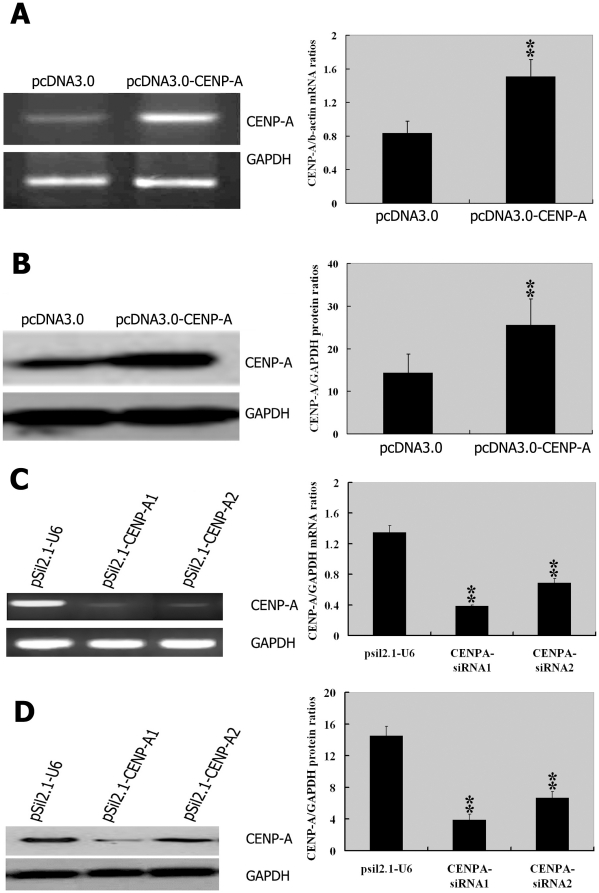
CENP-A overexpression and knockdown in HepG2 cells.Analysis of CENP-A mRNA (A, C) and protein (B, D) levels in HepG2 cells transfected with CENP-A-expressing plasmids or siRNA-expressing plasmids, as described in Materials and methods. A: RT-PCR (left) and qPCR (right) measurement of CENP-A transcript in cells transfected with pcDNA3.0-CENP-A or pcDNA3.0 empty vector. **
P<0.01 using Student's t-test; n = 3. B, left: Representative Western blots for CENP-A in cells treated as in A. Right: Quantification of the blotting shown in the left panel. **
P<0.01 using Student's t-test; n = 3. C: RT-PCR (left) and qPCR (right) examination of CENP-A mRNA levels in HepG2 cells transfected with CENP-A1, CENP-A2, or pSil2.1-U6 empty vector (control). **
P<0.01 compared to cells with the pSil2.1-U6, using one-way ANOVA; n = 3. D: Immunoblot of cells treated as in C. Left: Representative Western blots for CENP-A. Right: Quantification of the blotting shown in the left panel. **
P<0.01 compared to cells with the pSil2.1-U6, using one-way ANOVA; n = 3. GAPDH was used as an internal control in all the experiments.